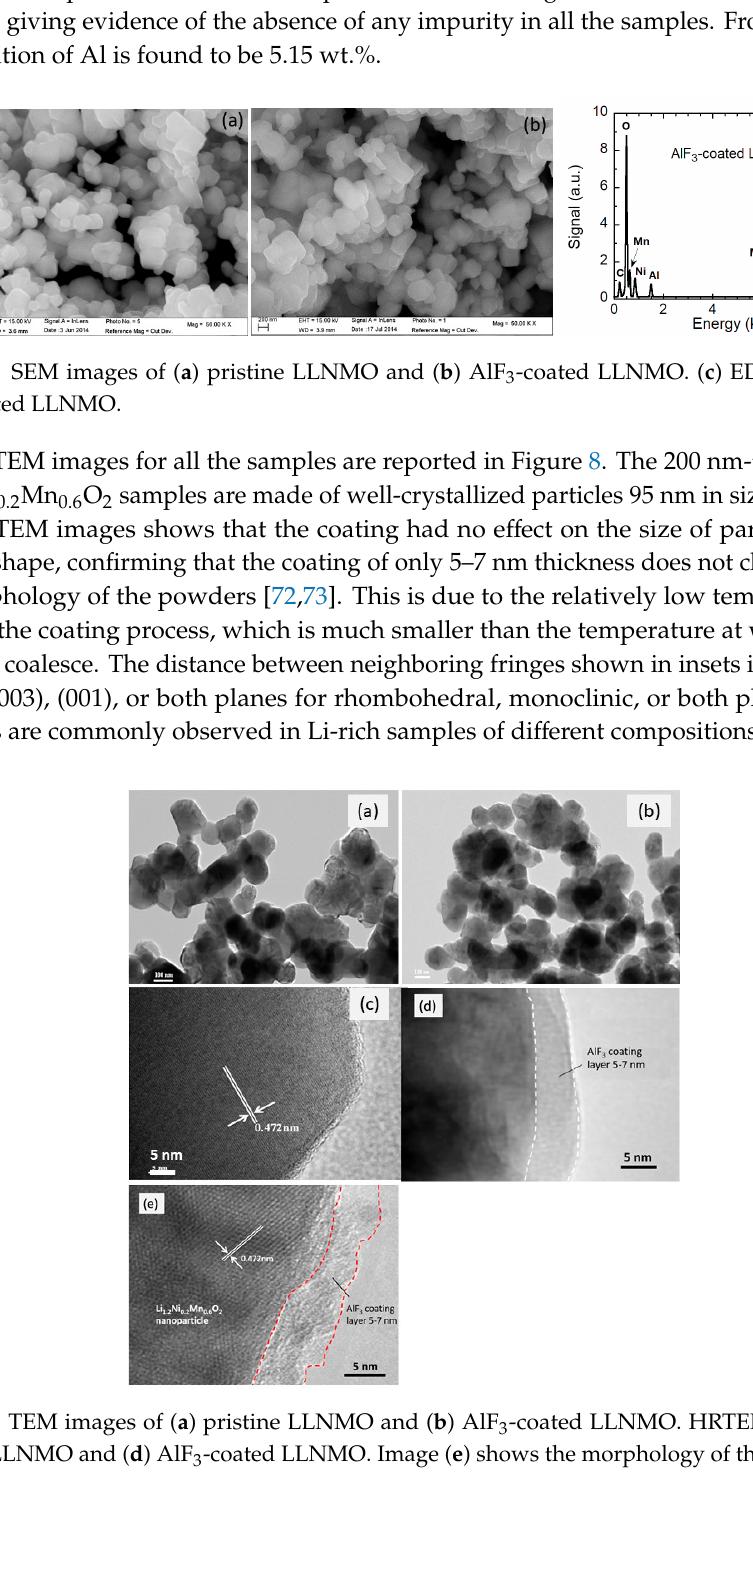
Figure 8. TEM images of ( a ) pristine LLNMO and ( b ) AlF 3 -coated LLNMO. HRTEM images of ( c ) pristine LLNMO and ( d ) AlF 3 -coated LLNMO. Image ( e ) shows the morphology of the AlF 3 coating.